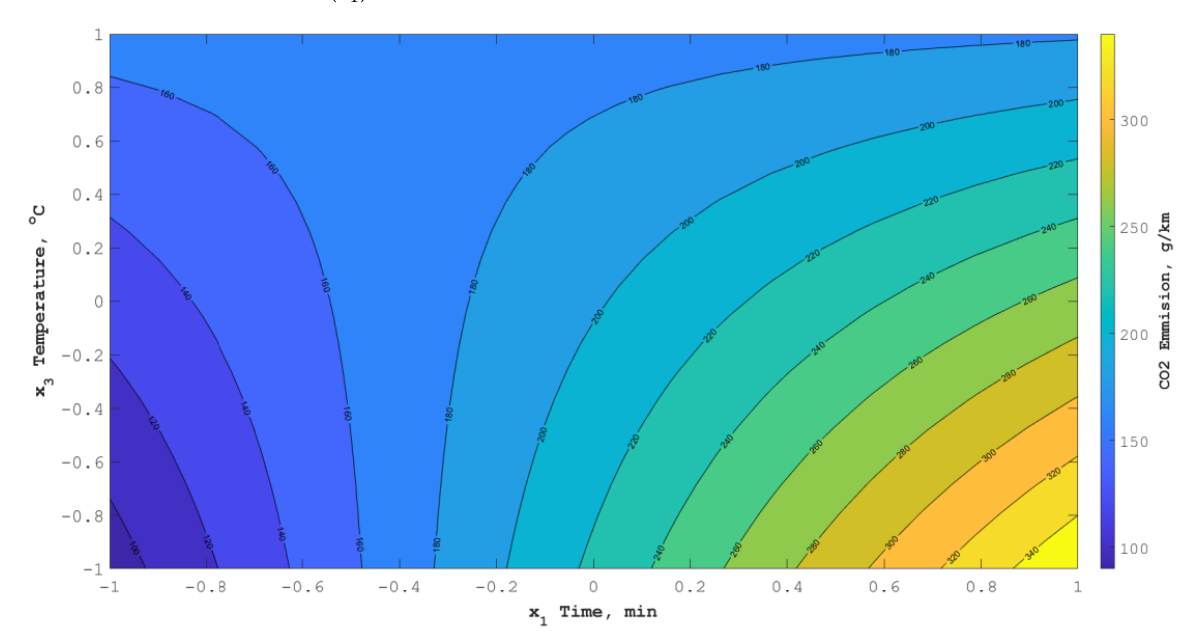
Figure 5. Change in CO 2 emissions depending on the variability of factors x 1 and x 3 for a vehicle (ICE) covering a distance of 2 km (x 2 = − 1).